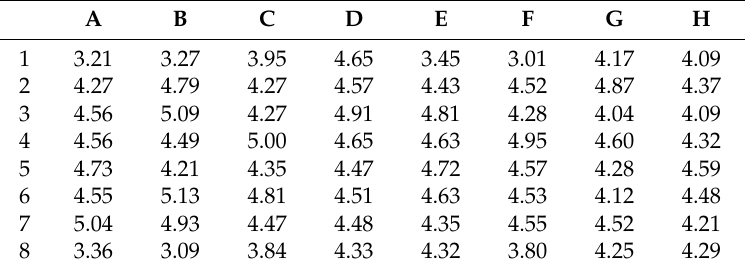
Table A13. Measured values of air velocity distribution in Experiment A5 (m/s). A